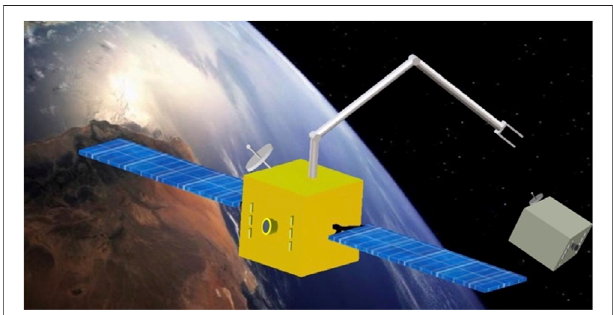
FIGURE 1 | A SMS operating on-orbit (Nanos and Papadopoulos,